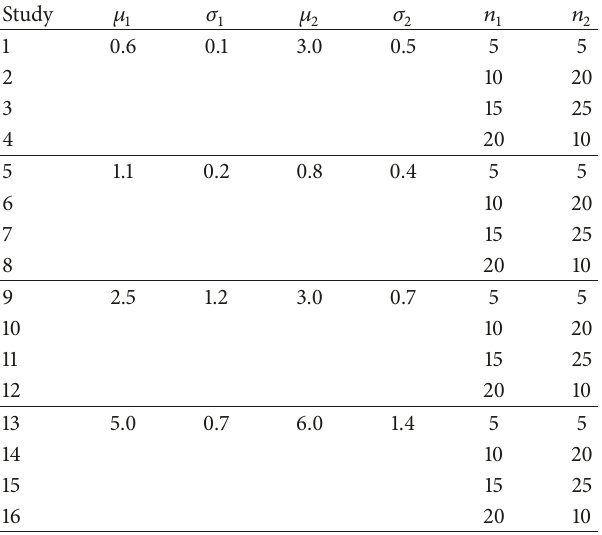
Table 2: Parameters settings for simulation studies.